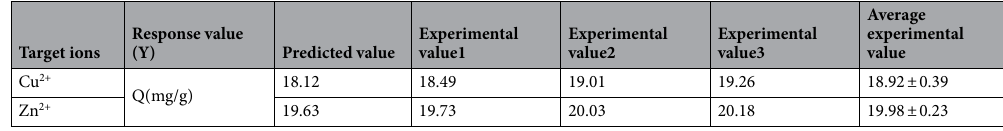
Table 4. Model predicted values and validated experimental values.